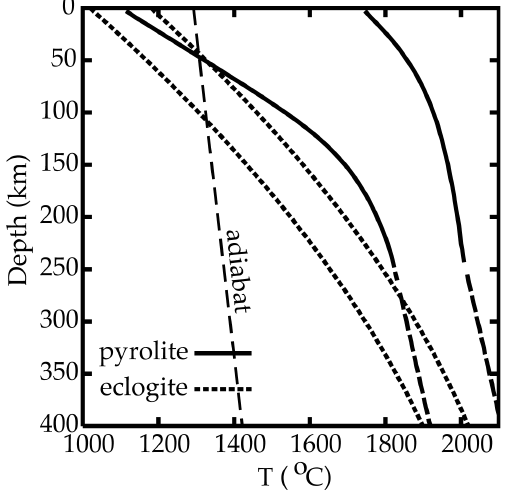
Fig. 13. Solidi (lower) and liquidi (upper) for an average man- tle composition (pyrolite) and for eclogite, the upper mantle form of subducted ocean crust. An approximate solid adiabat is in- cluded. After Yasuda et al. (1994). Copyright American Geophysi- cal Union.